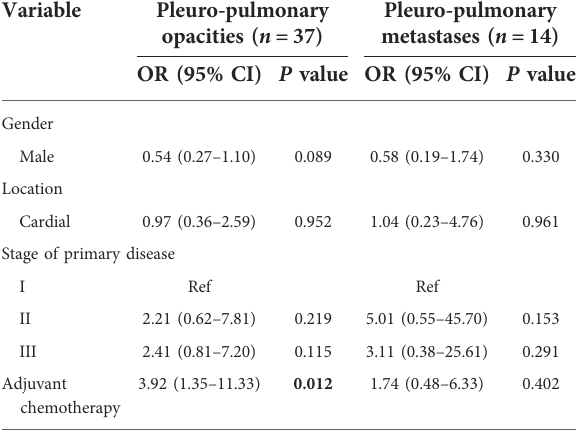
TABLE 2 Univariate analysis for predictors of developing pleuro- pulmonary opacities and metastases among patients with gastric adenocarcinoma treated with curative intent.